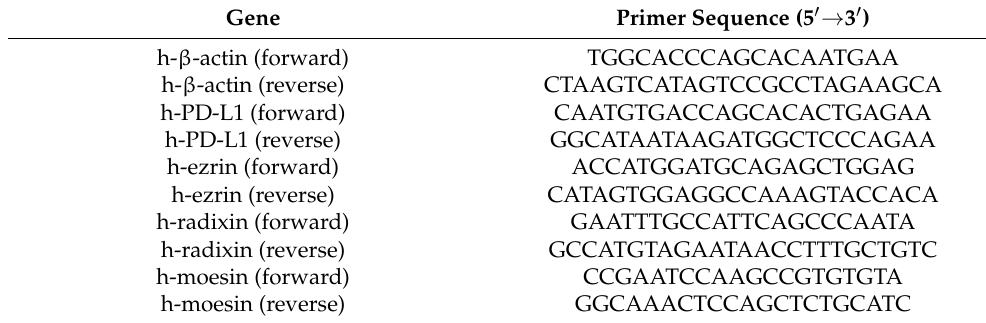
Table 1. Primer sequences used for quantitative reverse transcription-polymerase chain reaction analysis of gene expression.